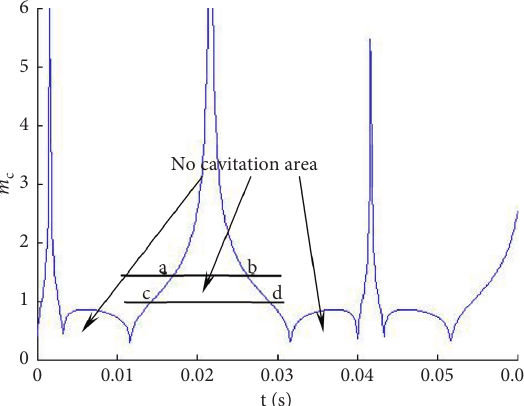
Figure 8: The change curve of the value of m